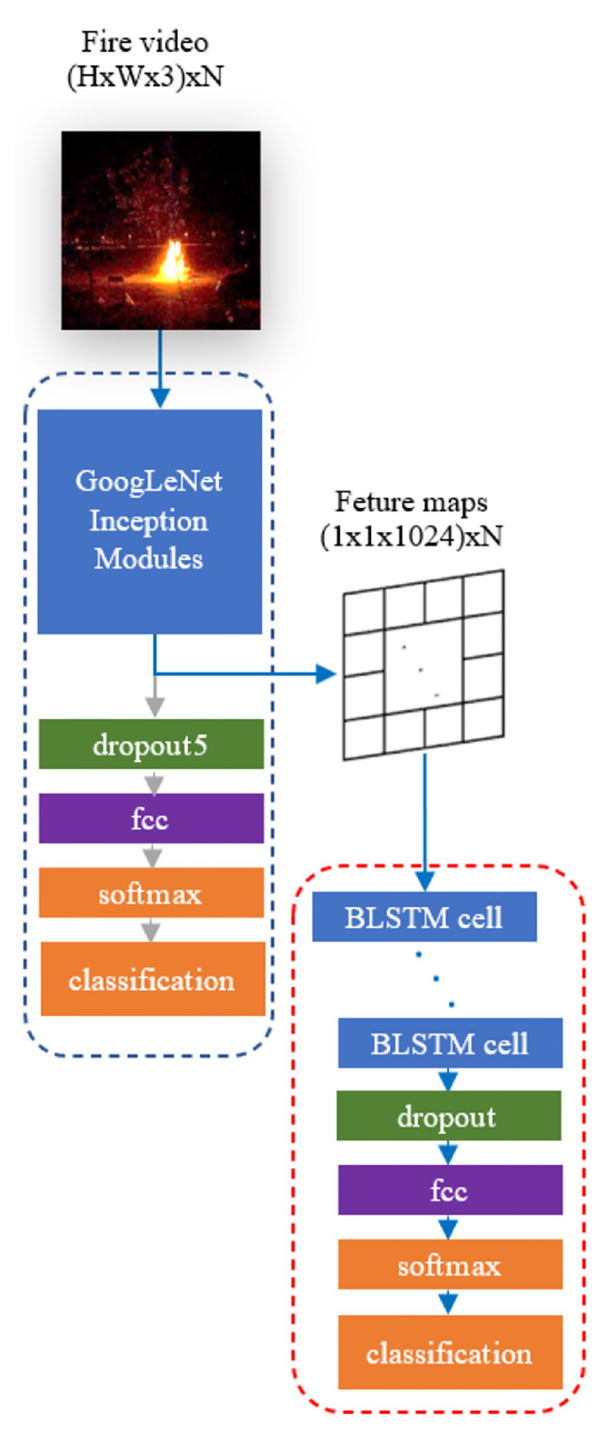
Fig 1. GoogLeNet+BLSTM architecture. In the dashed blue box, a standard GoogLeNet network structure is shown. GoogLeNet receives images or sequences of images in 224 × 224 size. In a dashed red box, a standard stacked BLSTM network structure is shown in rolled form. A BLSTM network receives a series of data in 1024 × 1 size. If N number of such vectors is the case, then input is in 1024 × N size. Blue arrows starting from the input video and ending at the classification box show the flow diagram of the proposed